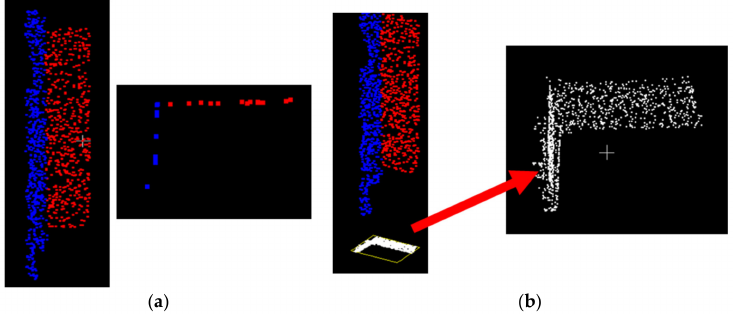
Figure 3. ( a ) 3D point clouds are projected onto a certain section; point clouds are few. ( b ) Planarized point cloud from proposed method has dense point